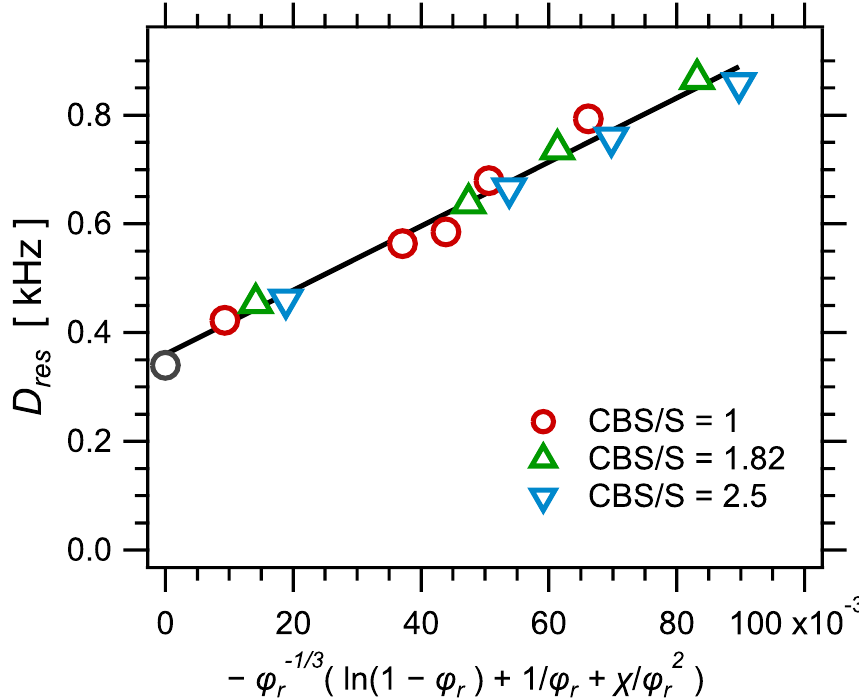
(cid:0) (cid:1) ln ( 1 − ϕ r ) + ϕ r + χϕ r 2 , ( 0 ) ≈ 0.35 corresponds to the contribution of res